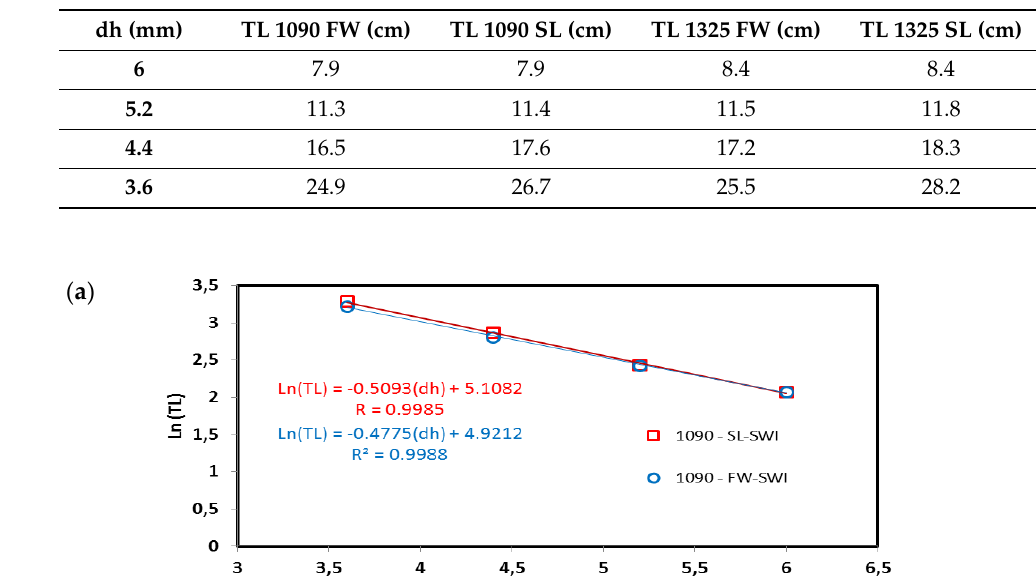
Table 2. Experimental toe length results in the FW and SL scenarios for the two bead sizes considered.